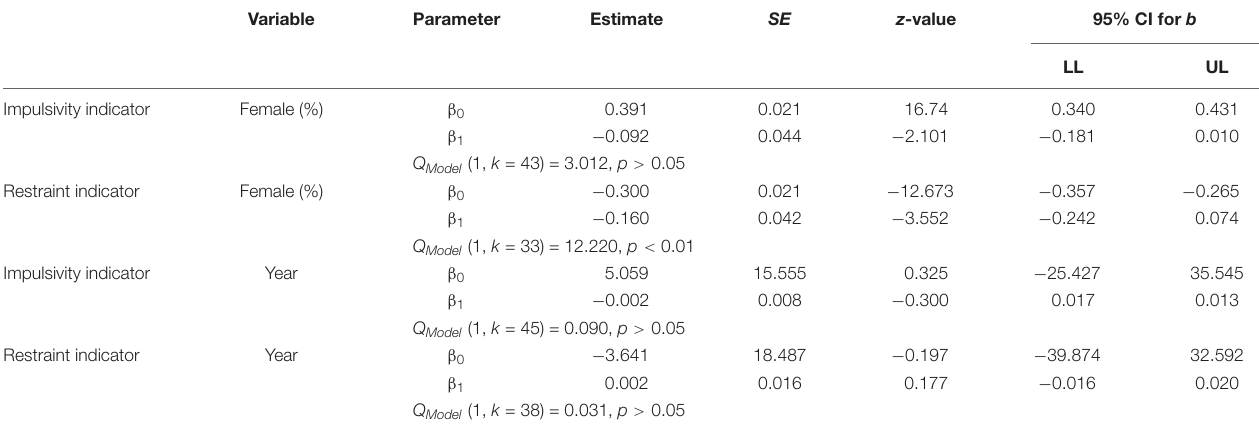
TABLE 4 | Meta-regression analyses of gender and